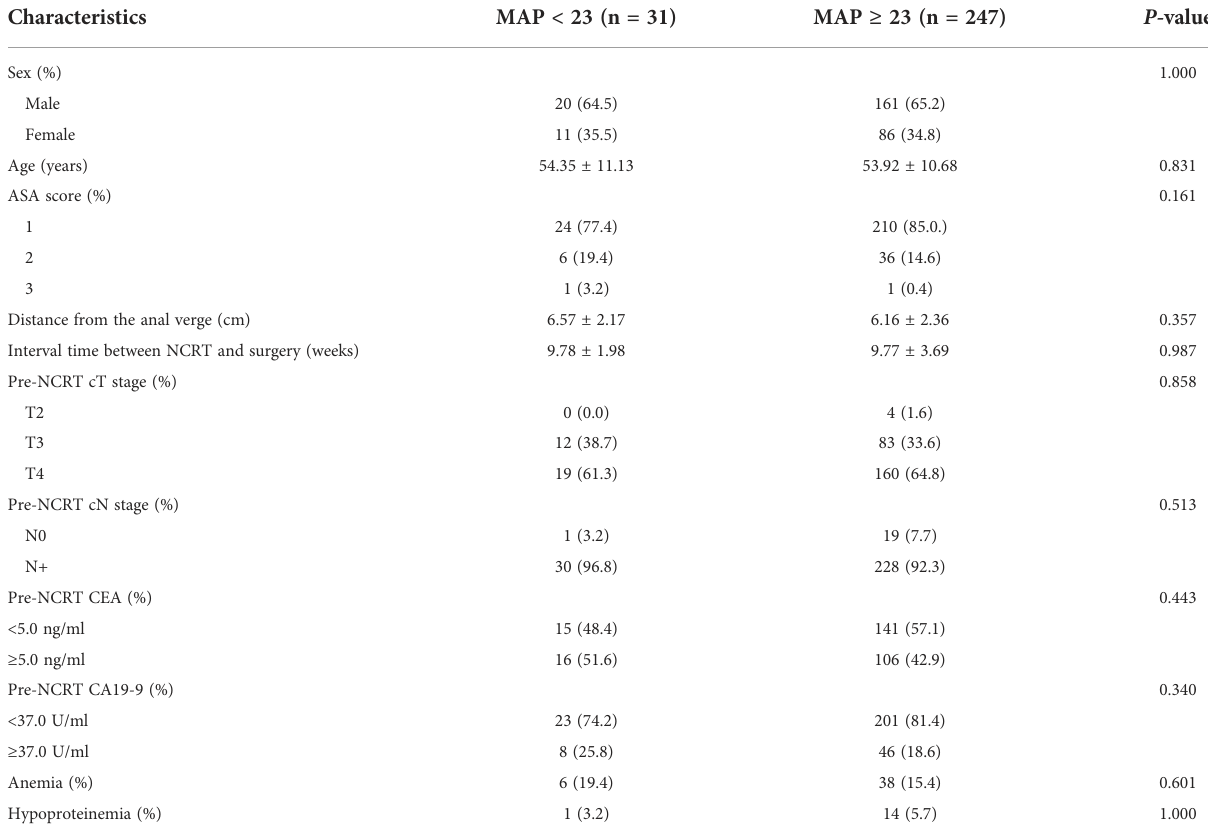
TABLE 1 Baseline characteristics in patients with LARC after NCRT strati fi ed by